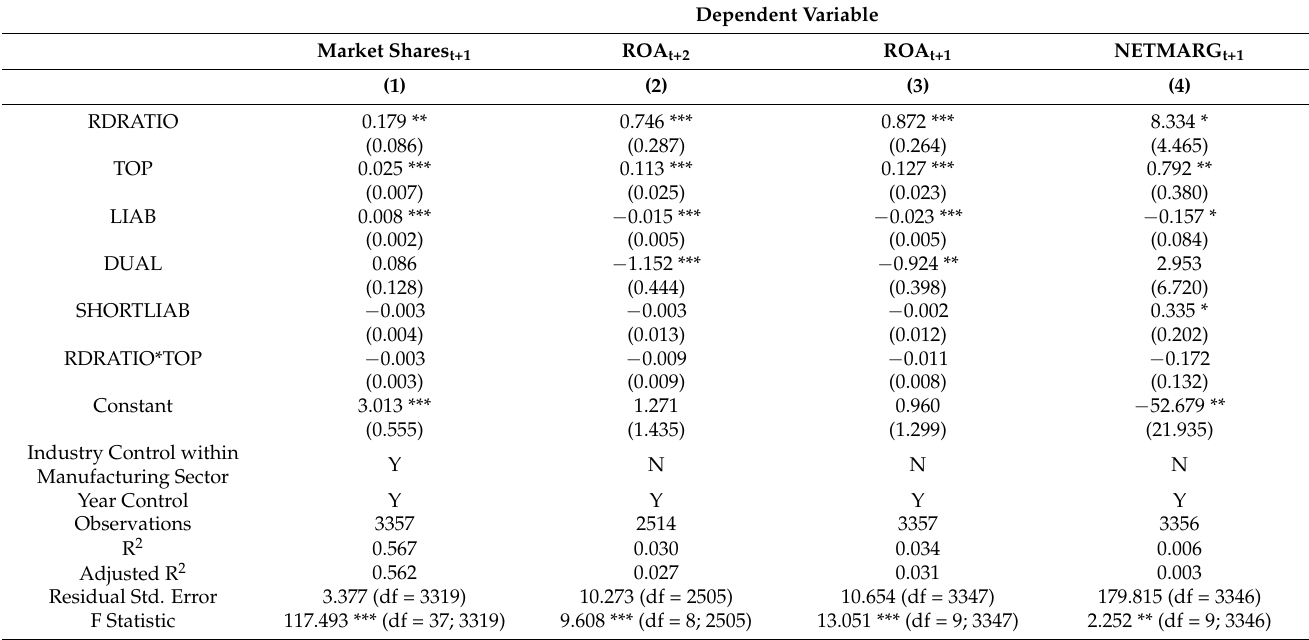
Table 9. Privately held firms.